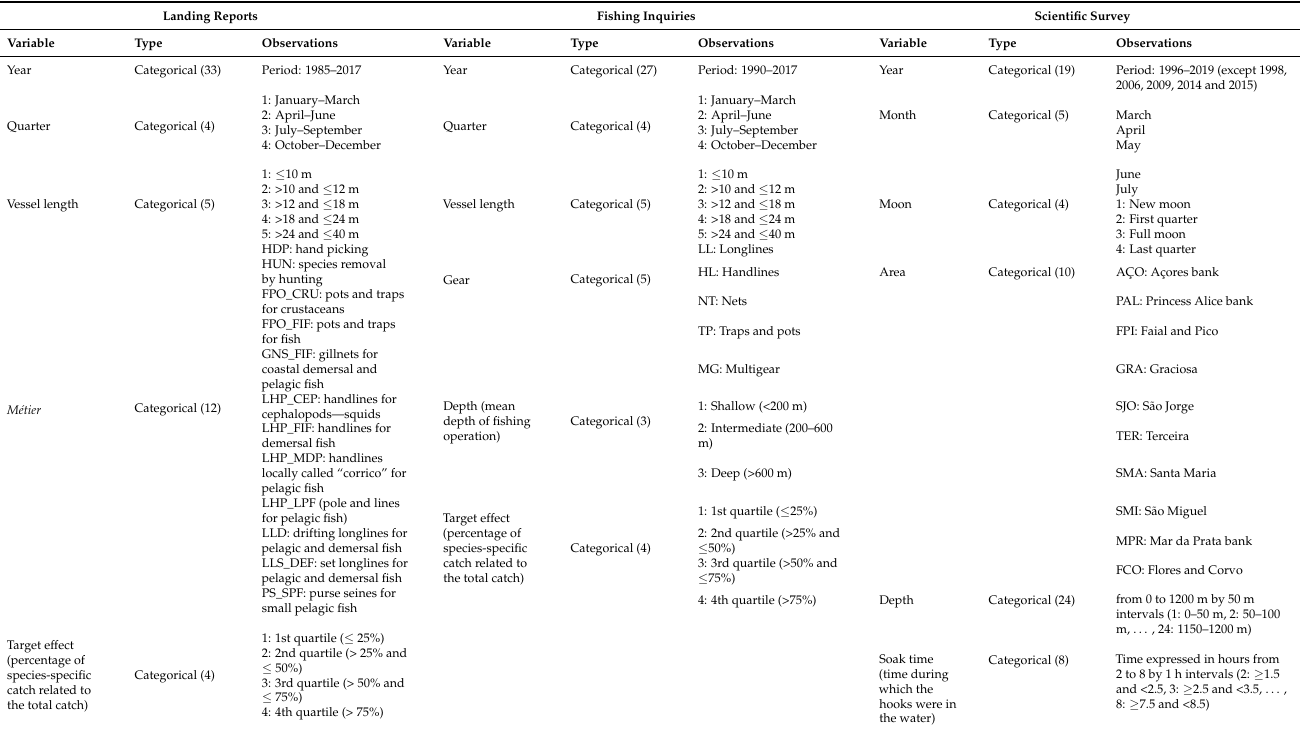
Table 1. Explanatory variables (main factors) used in the model formulations for standardized thornback ray Raja clavata , blackbelly rosefish Helicolenus dactylopterus (BRF), and common mora Mora moro catch